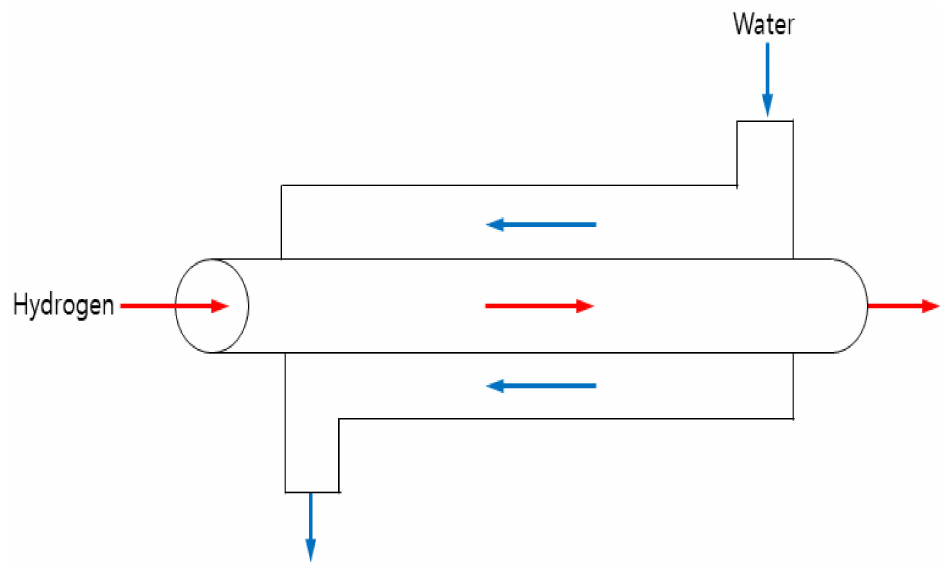
Figure 8. Counter flow heat exchanger. Table 5. Specifications and conditions of the heat exchanger.